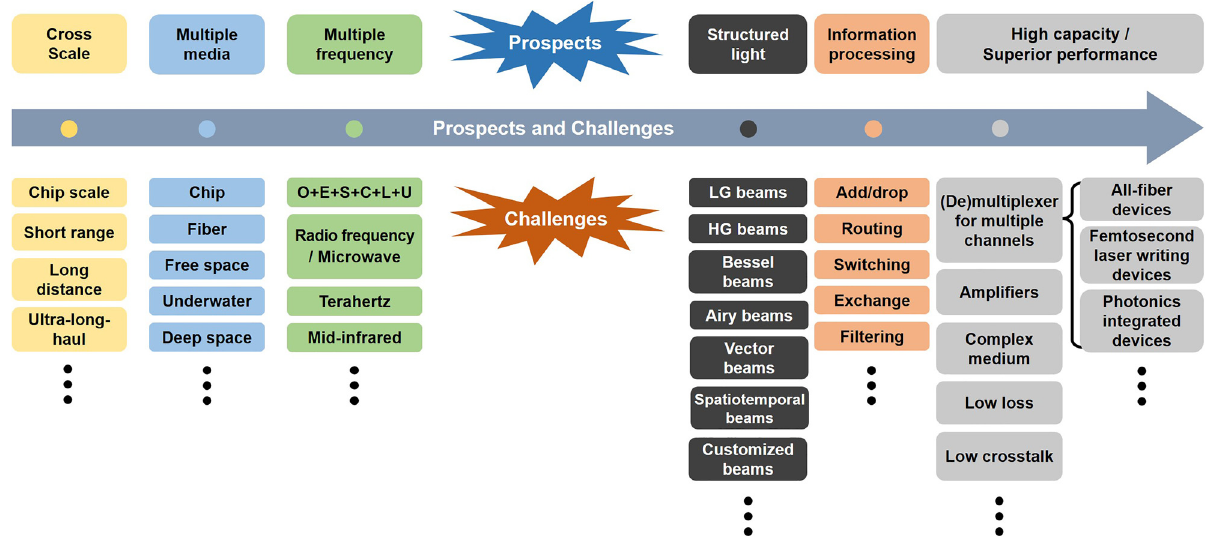
Figure 29: Prospects and challenges of optical communications using OAM and